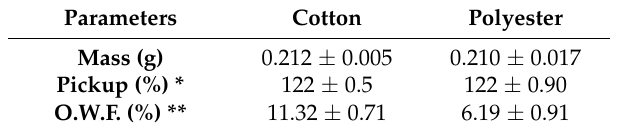
Table 3. Results of the finishing process with complexes in cotton and polyester fabric. Parameters Cotton